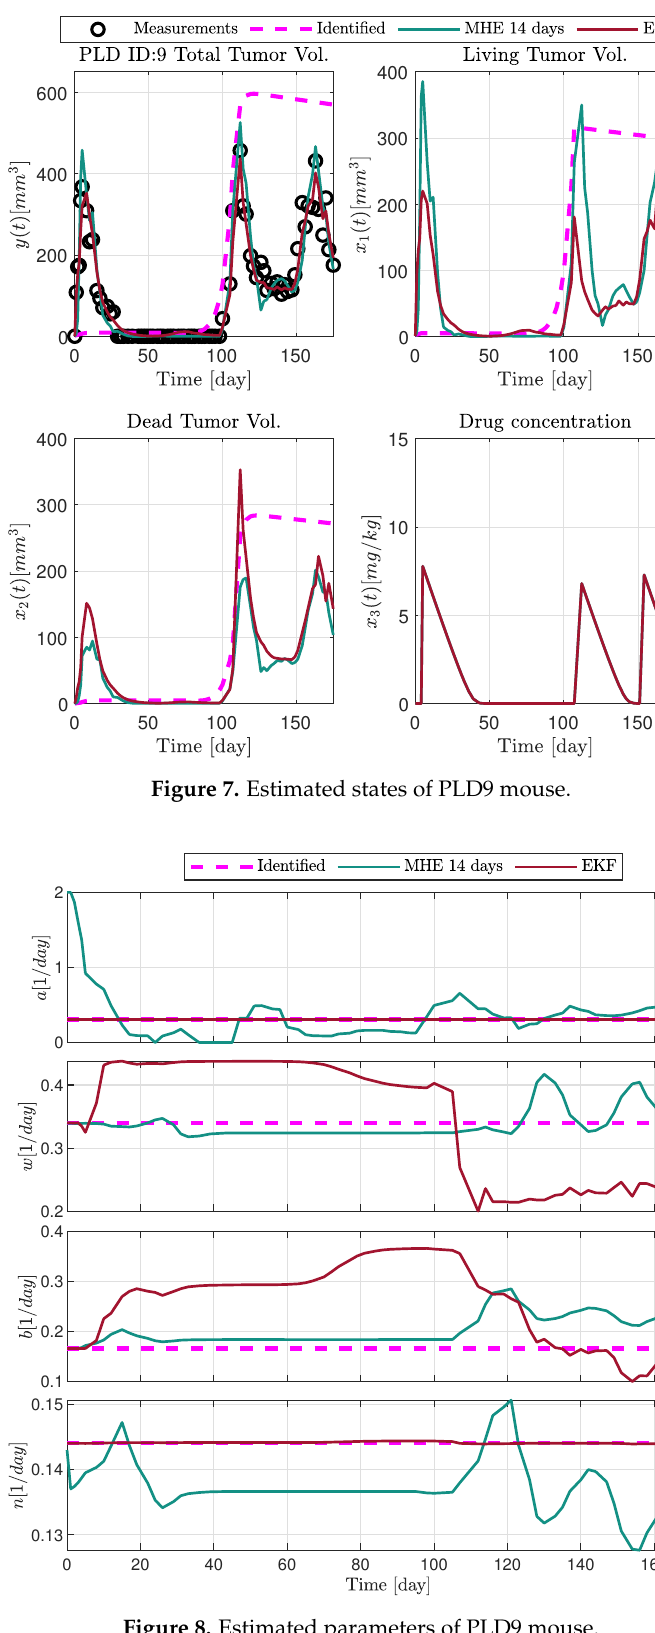
Figure 8. Estimated parameters of PLD9